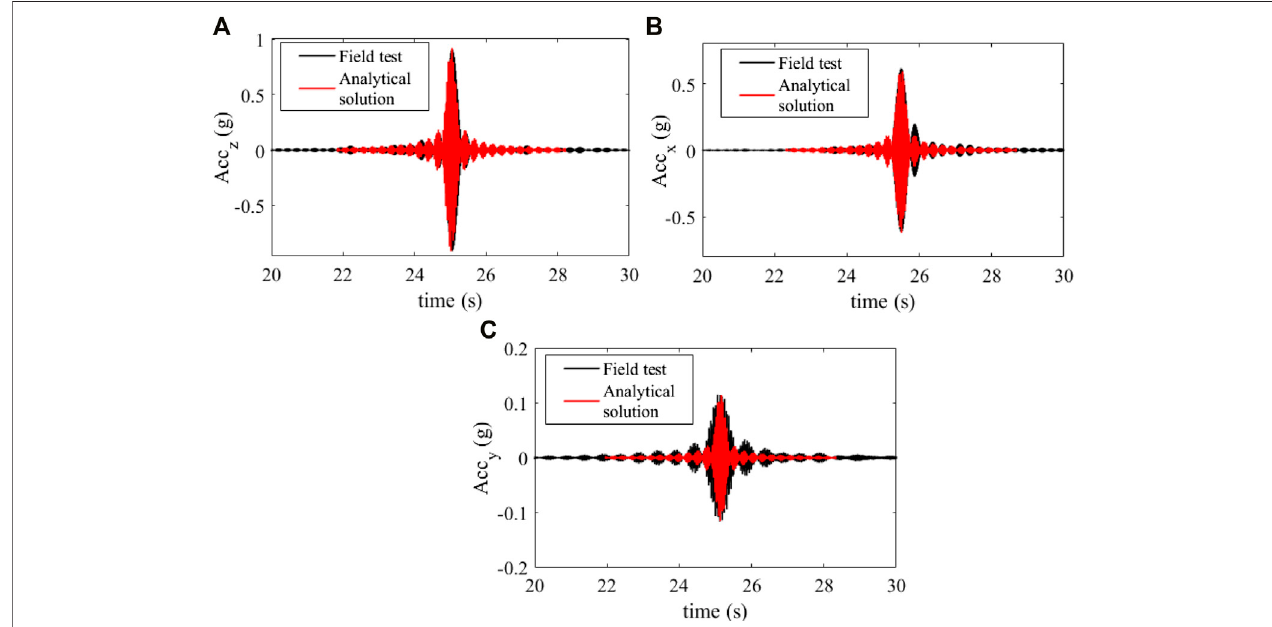
FIGURE 7 | Acceleration – time curve by calculation and